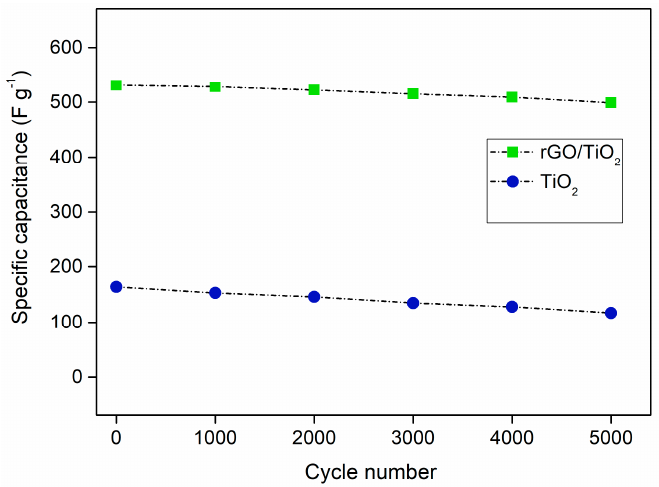
Figure 9. Specific capacitance versus cycle number.